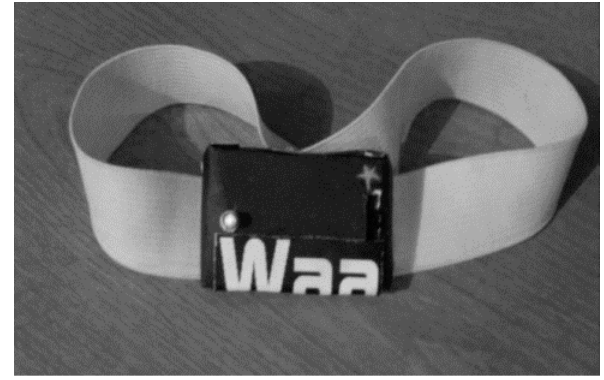
Figure 6. Head-tracking interaction device.